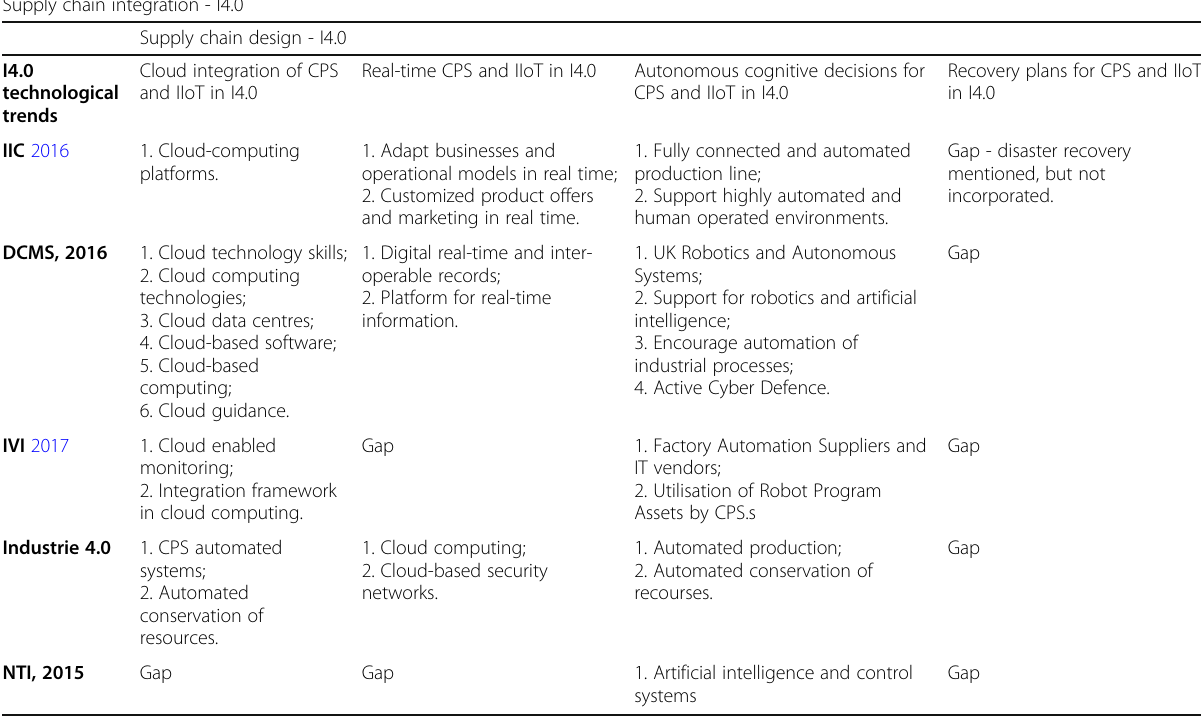
Table 7 Design principles emerging from the case study Supply chain integration - I4.0 Supply chain design -